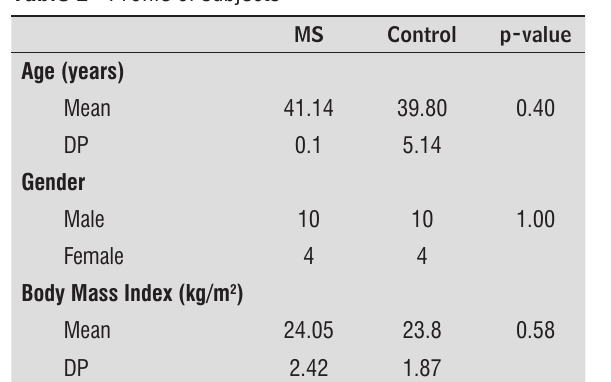
Figure 2 - COP displacement in the control and multiple scle- rosis